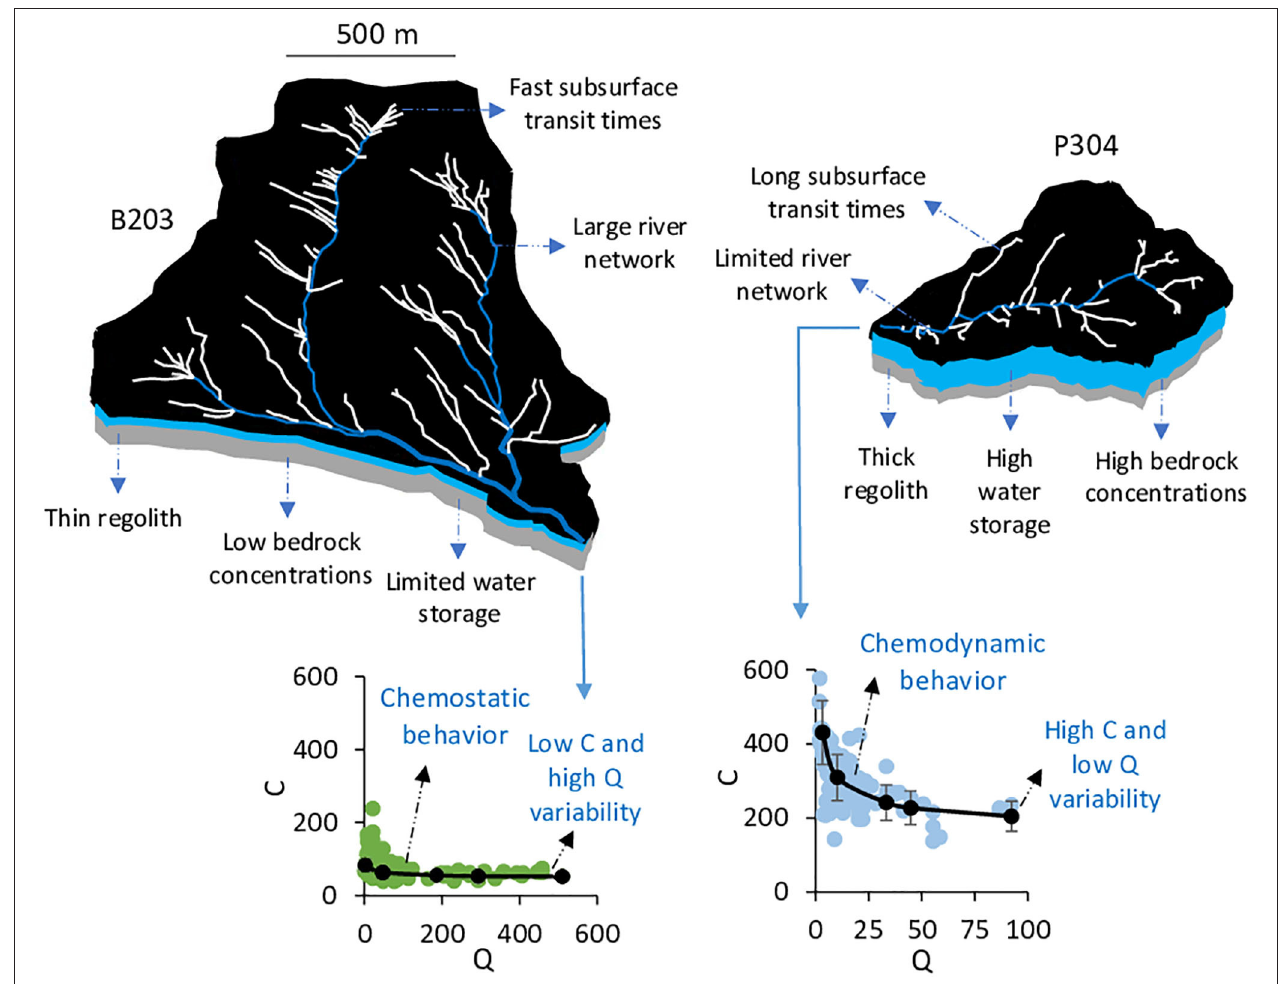
FIGURE 12 | Summary diagram of the CZ structures acquired through long-term processes that control the C-Q relations and hydrogeochemicaI behavior of watersheds. Thin regolith, large river network, fast subsurface transit times, limited water storage and low bedrock concentrations enhance low mean concentrations and chemostatic behavior for the stream waters. In contrast, thick regolith, limited stream networks, slow subsurface transit times, high water storage and high bedrock concentrations enhance high mean concentrations and chemodynamic behavior for the